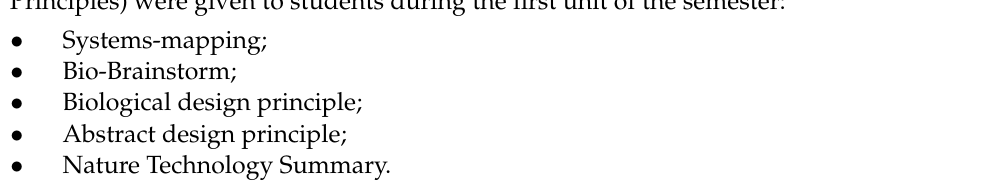
Table 1. Research context, participants and other